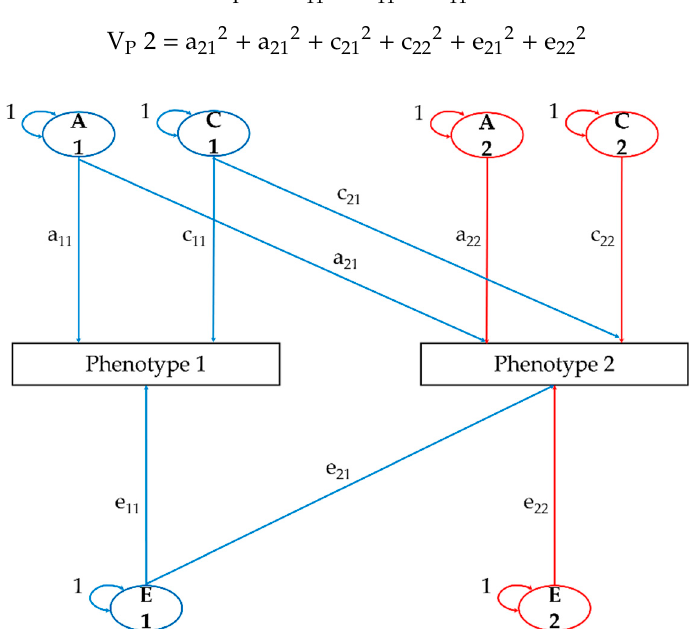
Figure 2. Path diagram for the bivariate Cholesky decomposition model. Subscripts with paths indicate a path direction and an origin (e.g., for a 21 , 2 is the path direction phenotype 2, and 1 is the origin). ( A ) Additive genetic factor; ( a ) the path from a genetic factor; ( C ) shared environmental factor; ( c ) the path from a shared environmental factor; ( E ) non-shared environmental factor; ( e ) the path from a non-shared environmental factor.